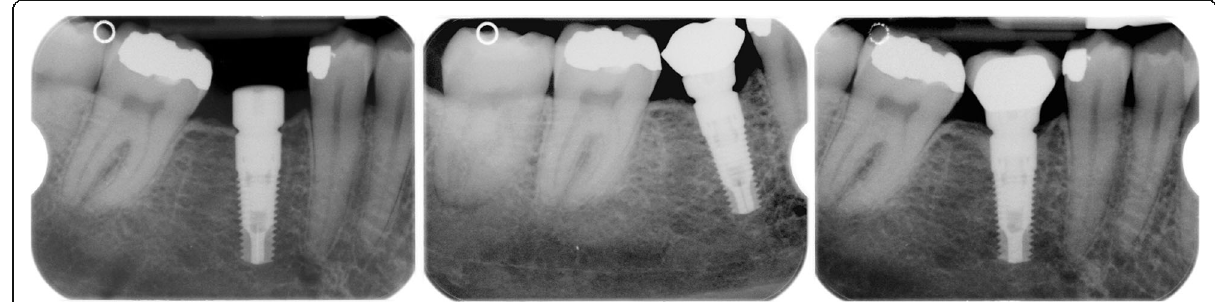
Fig. 1 Illustrative case of radiological follow-up period in the mandible. T0 in the left image, T1 in the central, and T2 in the